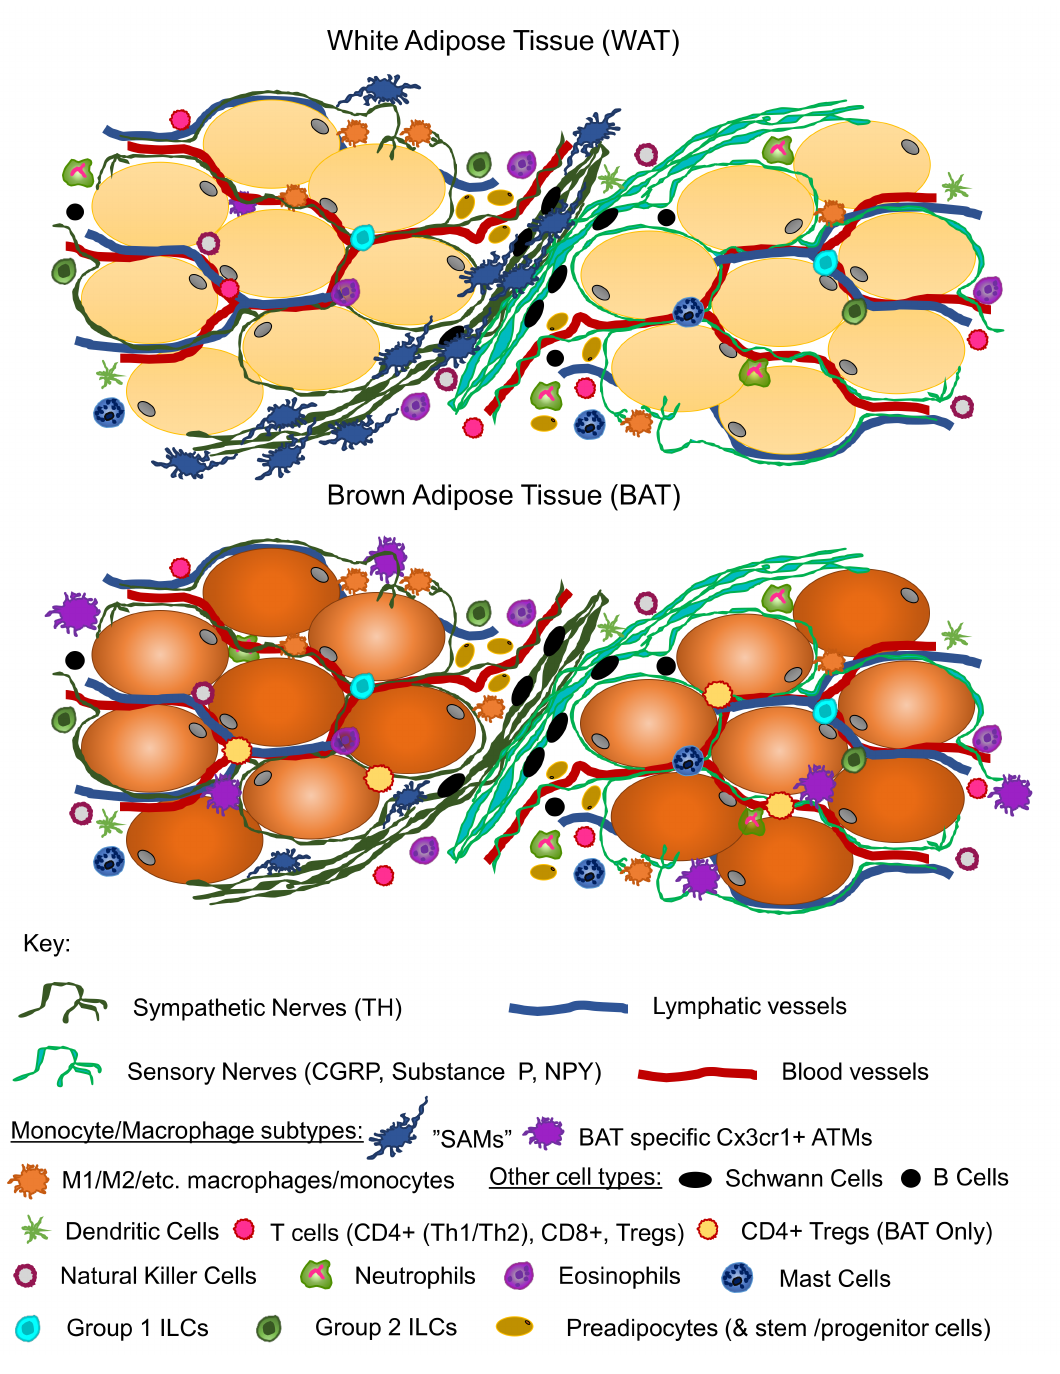
Figure 1. Architecture and neuroimmune cell types in white (WAT) and brown adipose tissue (BAT) in the basal state. Both WAT and BAT are comprised of lipid-laden mature adipocytes, where white adipocytes have one large (or unilocular) lipid droplet and brown adipocytes have many small (or multilocular) lipid droplets. The stromal vascular fraction (SVF) is the non-adipocyte cell fraction of the tissue, and contains preadipocytes (and stem/progenitor cells that will undergo white or brown adipogenesis) and a milieu of immune cells. Immune cell populations include innate immune cells, such as several subtypes of monocyte-macrophages, dendritic cells, mast cells, neutrophils, eosinophils, and innate lymphatic cells (ILCs); as well as adaptive immune cells, such as several subsets of T